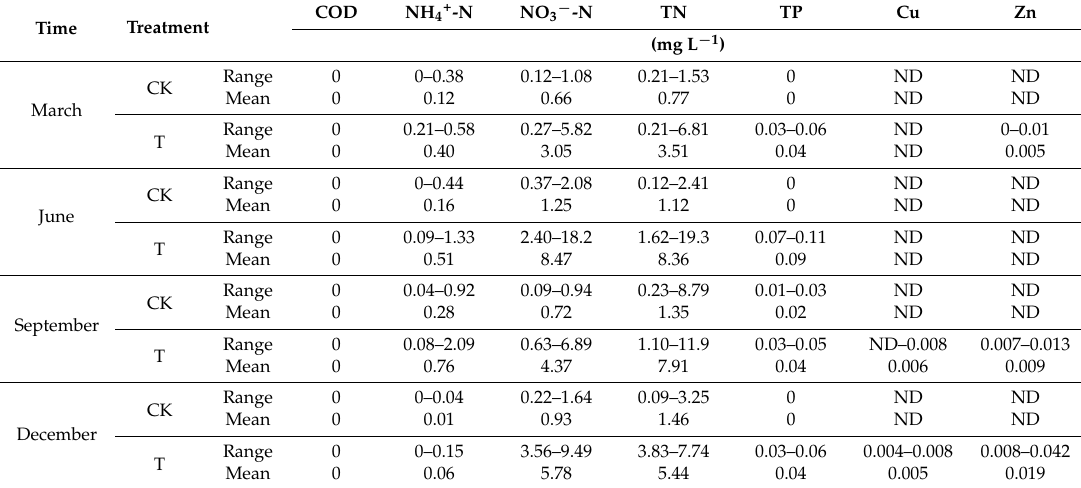
Table 6. Quality of the groundwater in the vicinity of sample pig